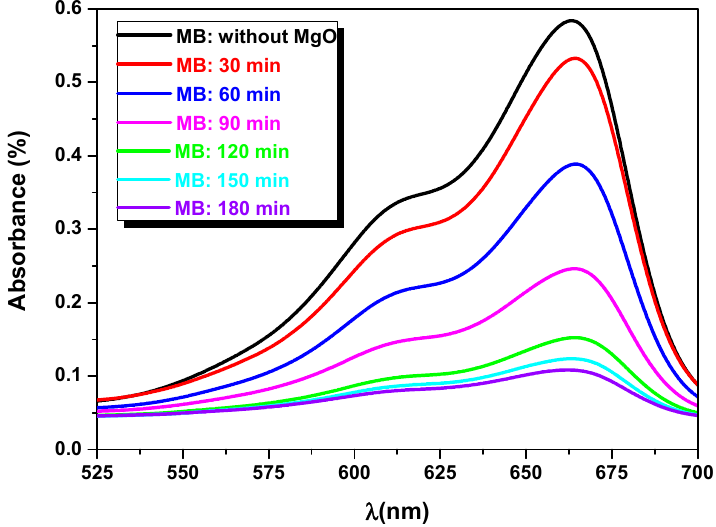
Figure 9. The temporal change in the original MB solution (0 min) and with MgO thin films under sunlight irradiation for different times (30, 60, 90, 120, 150 and 180 min).